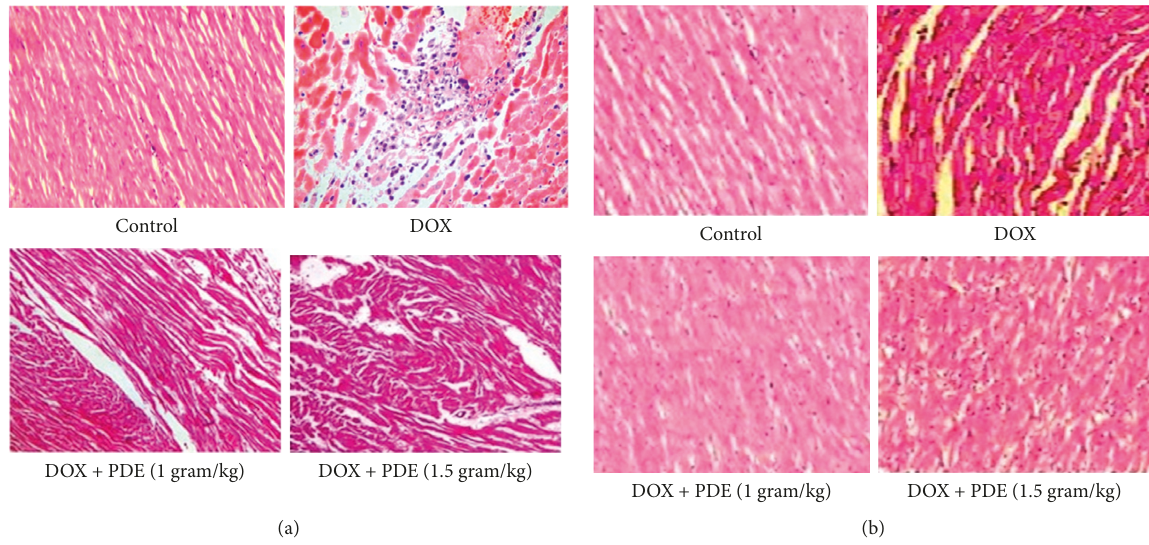
Figure 5: Histopathological analysis of the section of the heart: (a) control (N/S 4ml/kg); DOX (10 mg/kg); DOX+PDE (1 gram/kg); and DOX+PDE (1.5gram/kg) in doxorubicin-induced cardiotoxicity. Histopathological analysis of the section of the kidney: (b) control (N/S 4ml/kg); DOX (10mg/kg); DOX+PDE (1gram/kg); and DOX +PDE (1.5gram/kg) in doxorubicin-induced